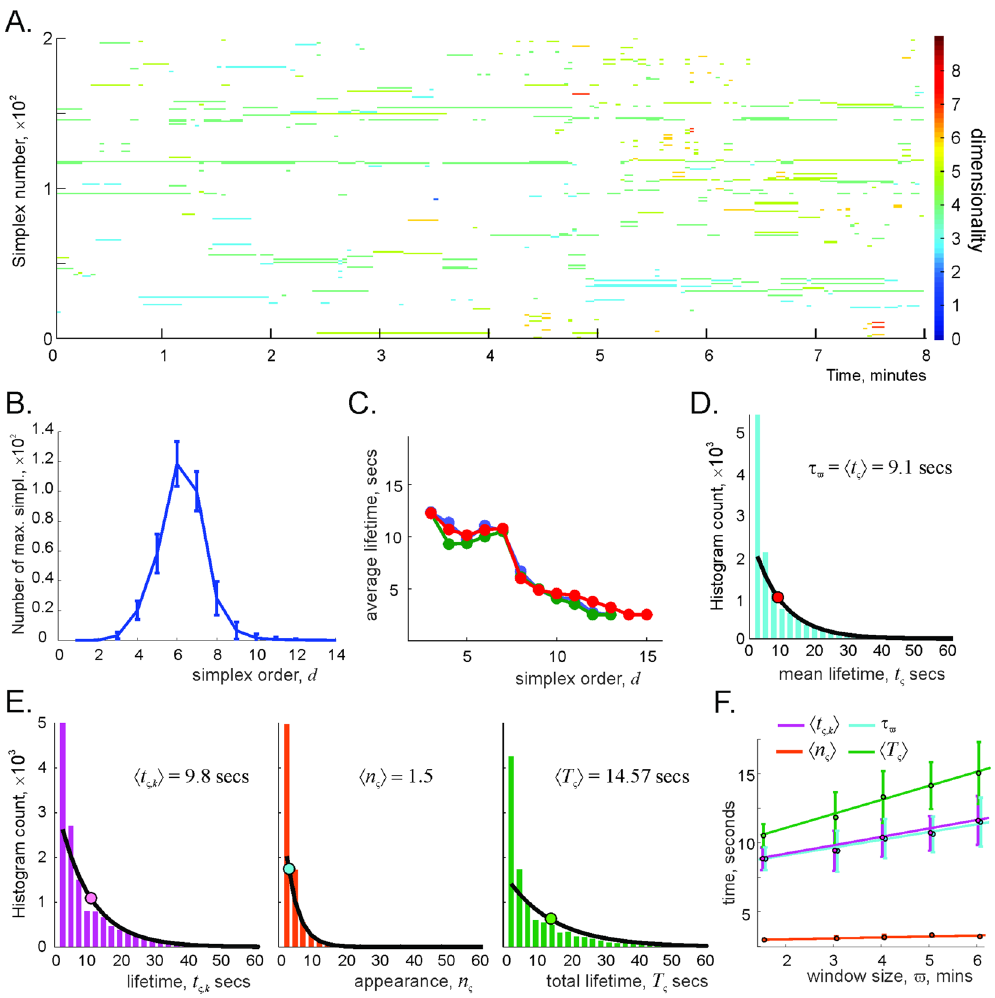
Figure 3. Fluctuating simplexes. ( A ) Each strike represents a timeline of a particular maximal simplex ς , computed for the coactivity window ϖ = 4 min. There are about N ς = 320 maximal simplexes at every given timestep (first 200 are enumerated along the y -axis), whereas the total number of maximal simplexes observed during the entire navigation period is about 11,000. The color of the timelines marks the order of ς (colorbar on the right). Notice that the simplexes of lower orders generally persist over longer intervals. ( B ) Number of maximal simplexes as a function of their order has a Gaussian shape with the mean d = 7 and standard deviation Δ ≈ ± 2, suggesting that a typical cell assembly contains about seven neurons and about two neurons may d appear or disappear from it at a given moment. ( C ) Average existence time of the maximal simplexes tends to decay with increasing order. ( D ) Histogram of the maximal simplexes’ individual average lifetimes t ς fit with the exponential distribution with mean τ ϖ = 9 s, defining the half-life of the simulated cell assemblies for this ϖ . ( E ) Histogram of the maximal simplexes’ lifetimes t ς ,, k , i.e., of the lengths of all intervals between consecutive appearance and disappearance of the maximal simplexes, the histogram of the number of simplex-births n ς and the histogram of the total existence periods T ς fit with their respective exponential distributions. The mean number of simplex’ appearances 〈 n ς 〉 ≈ 1.5 shows that most maximal simplexes appear only once or twice, though some maximal simplexes may appear 20 times or more. Notice that the mean net existence period 〈 T ς 〉 ≈ 14.57 s is approximately equal to the product of the mean lifetime and the mean number of appearances 〈 T ς 〉 ≈ 〈 n ς 〉 〈 t ς ,, k 〉 . ( F ) As the size of the memory window ϖ increases, the lifetimes, half-lives, and net existence periods of the maximal simplexes grow linearly with ϖ